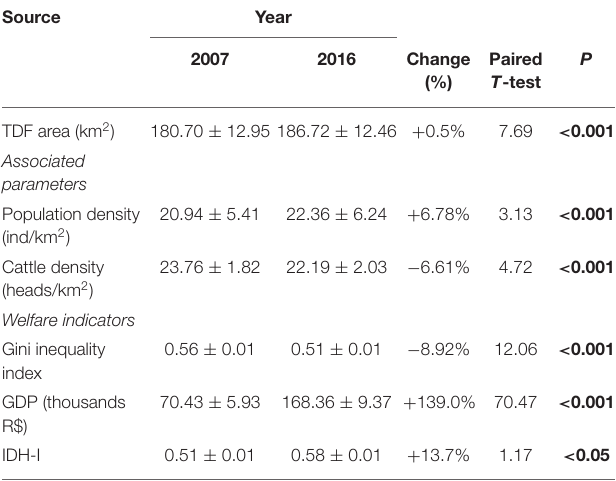
TABLE 3 | Average tropical dry forest (TDF) area, factors associated with land cover change and welfare indicators for the years 2007 and 2016 per county (mean ± standard